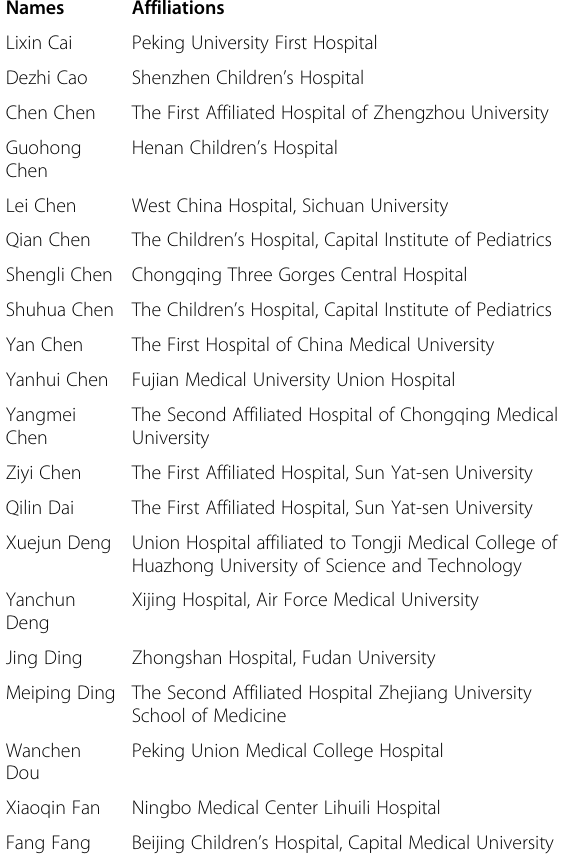
Abbreviations ASMs: Anti-seizure medications; CAAE: China Association Against Epilepsy; COVID-19: Coronavirus disease 2019; GDP: Gross domestic product; WHO: World Health